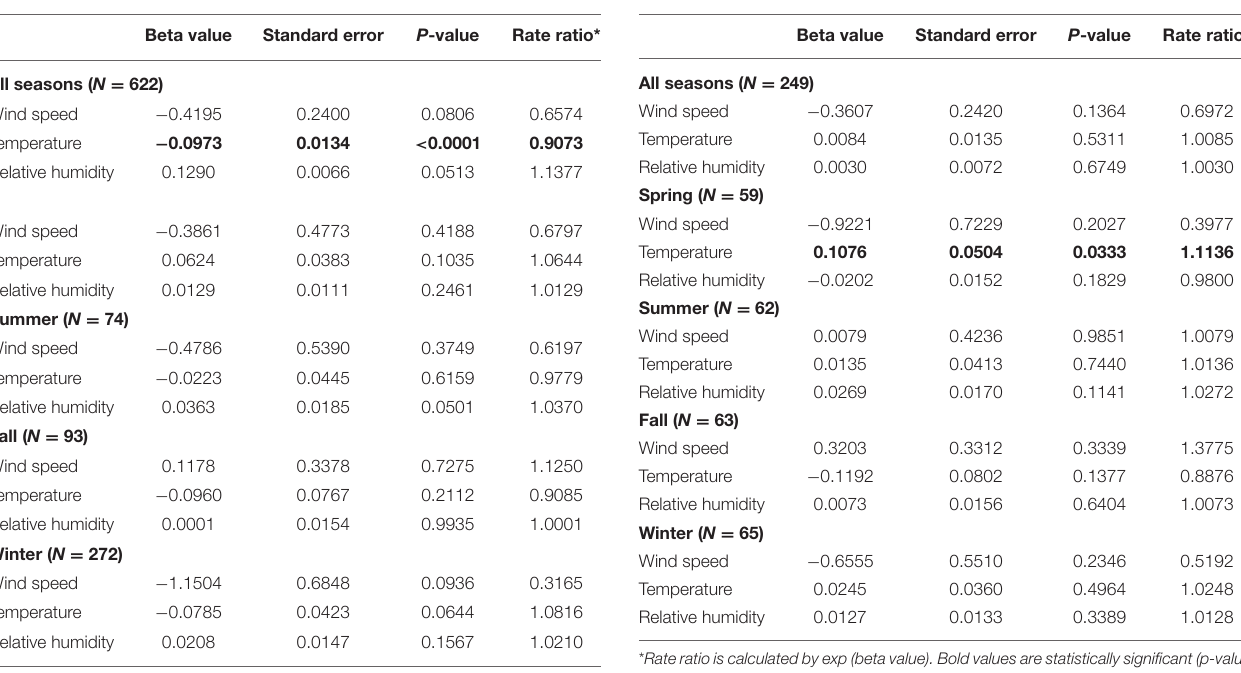
TABLE 3 | Subgroup analyses of the changes of weather parameters on the incidence of intentional CO poisoning.